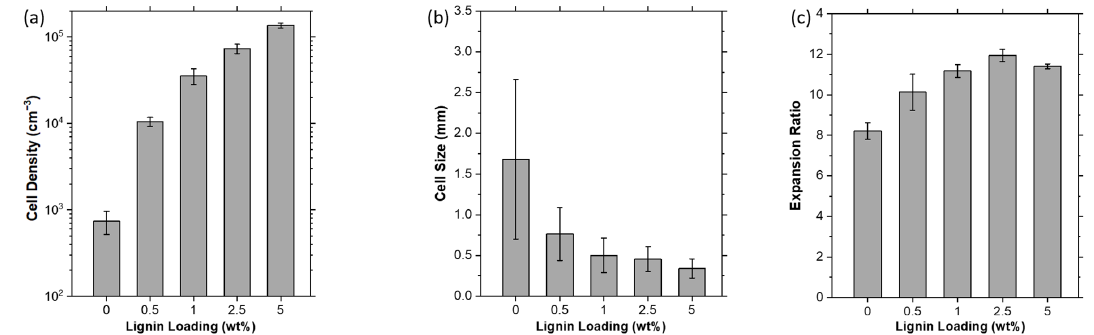
Figure 4. ( a ) Cell density, ( b ) cell size, and ( c ) Expansion Ratio of the PP and PP/lignin foams.